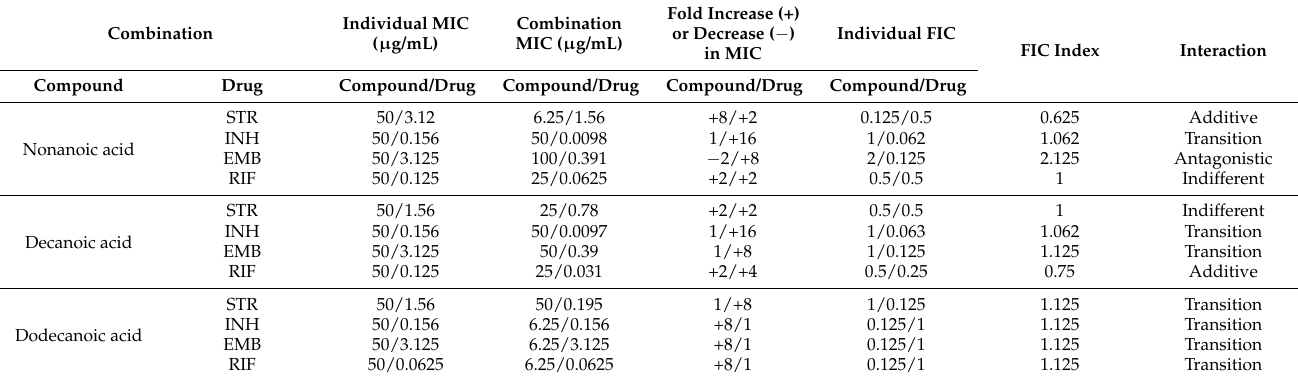
Table 3. Interactions of compounds with first-line antituberculosis drugs against Mycobacterium tuberculosis